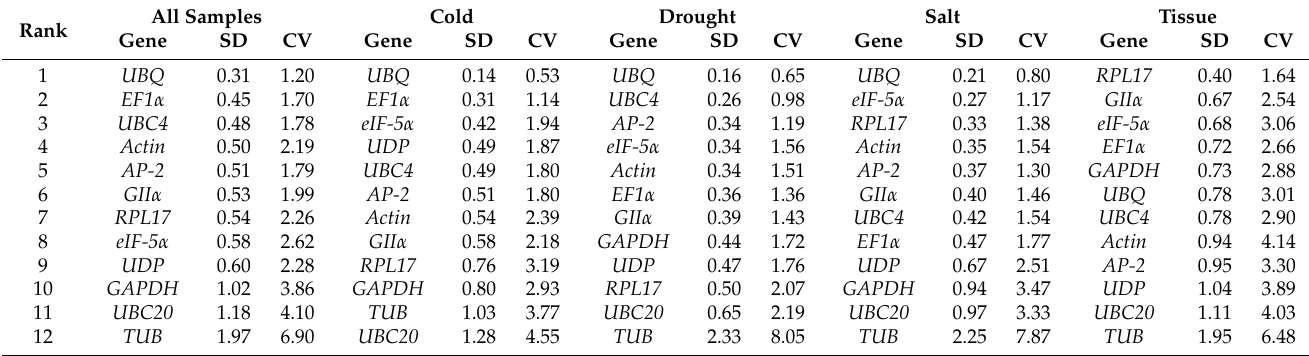
Table 3. Stability analysis of candidate reference genes based on BestKeeper algorithm.